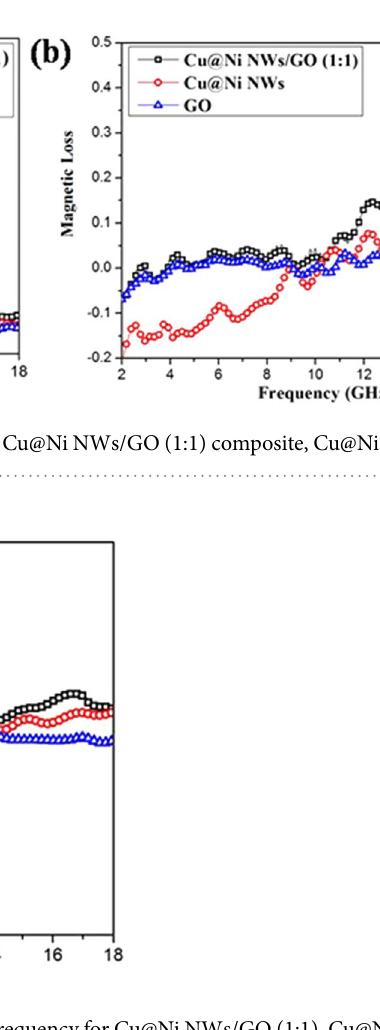
Figure 8. The values of C 0 = μ′′ ( μ′ ) − 2 ƒ − 1 versus the frequency for Cu@Ni NWs/GO (1:1), Cu@Ni NWs and GO in the frequency range of 2.0–18.0